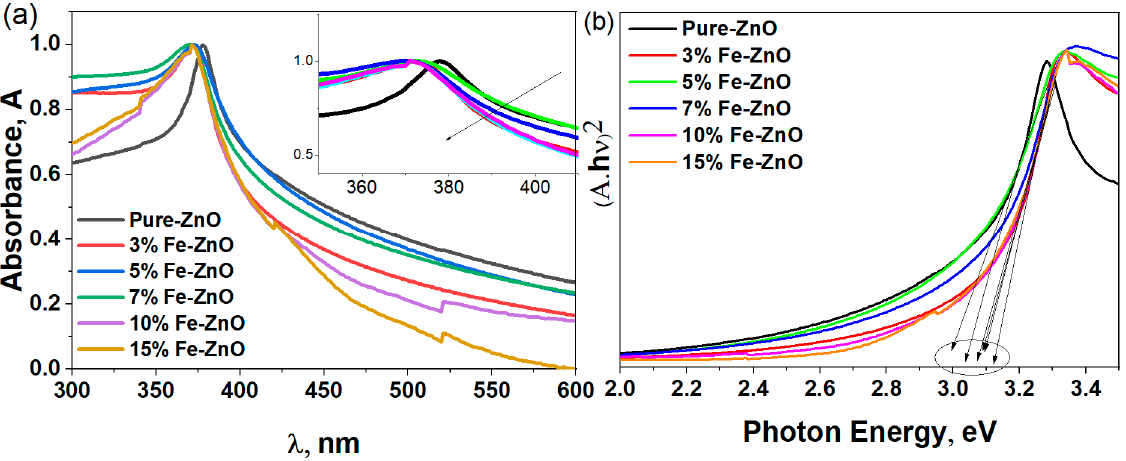
Figure 4. (UV-vis) absorption spectra of Zn 1 − x Fe x O, the absorption band gets a blue shift (370–380 nm), as shown in ( a ), ( b ) Tauc’s relation.